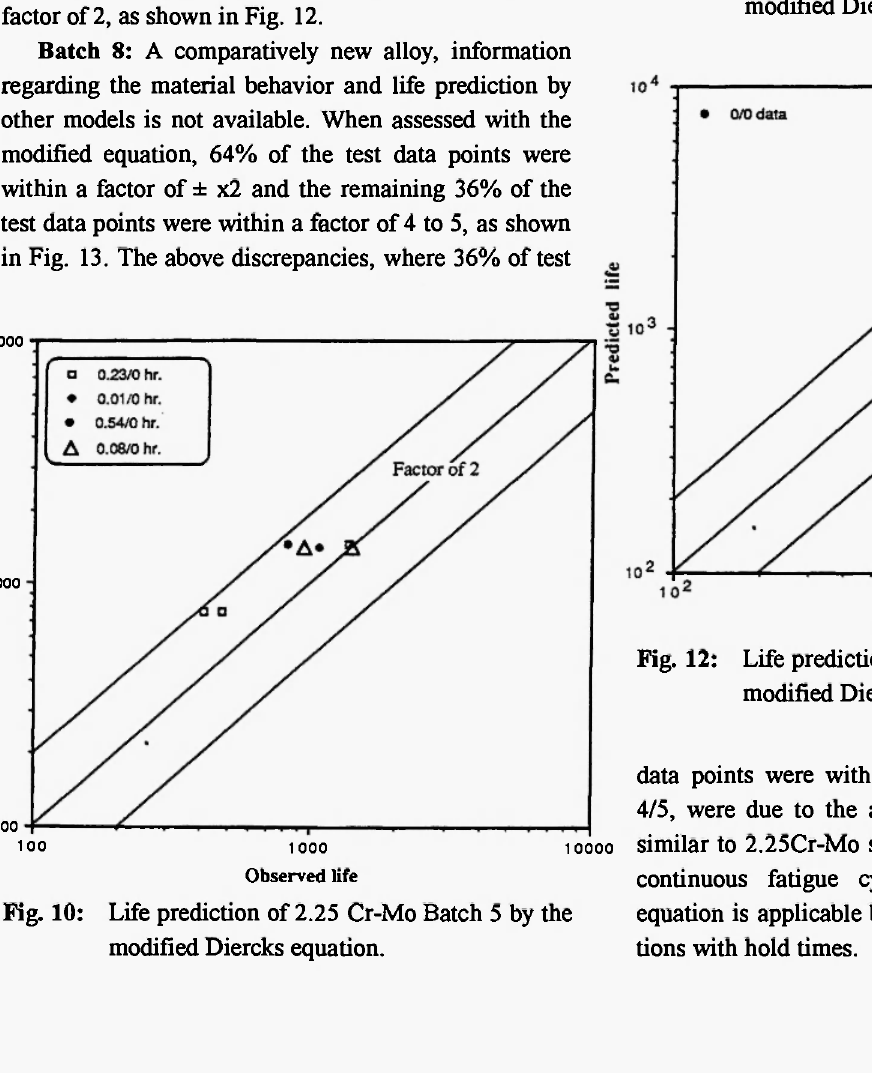
Fig. 11: Life prediction of 2.25 Cr-Mo Batch 6 by the modified Diercks equation.